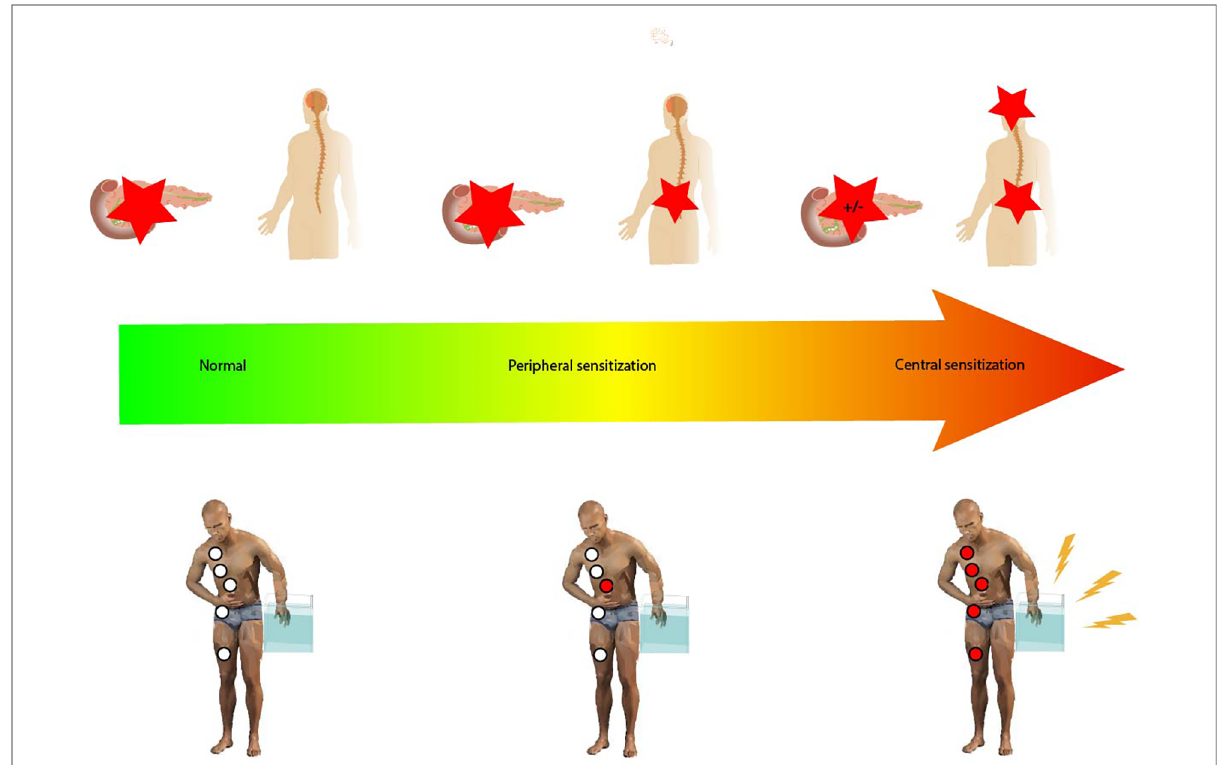
FIGURE 1 Pain responses ranging from normal through peripheral sensitization to central sensitization. Peripheral sensitization is characterized by increased excitability of the second-order neurons sharing spinal innervation with the pancreatic gland but lacking changes in the central pain processing pathways. Central sensitization is associated with changes in central pain processing pathways. The red stars indicate the generation of a nociceptive response to stimulation, either peripherally or centrally. Hypersensitivity as tested by the P-QST study protocol (pain thresholds as well as temporal summation) is indicated by the red circles; white circles indicate normal P-QST responses. In central sensitization, dynamic QST measures such as conditioned pain modulation can also be affected as shown in the fi